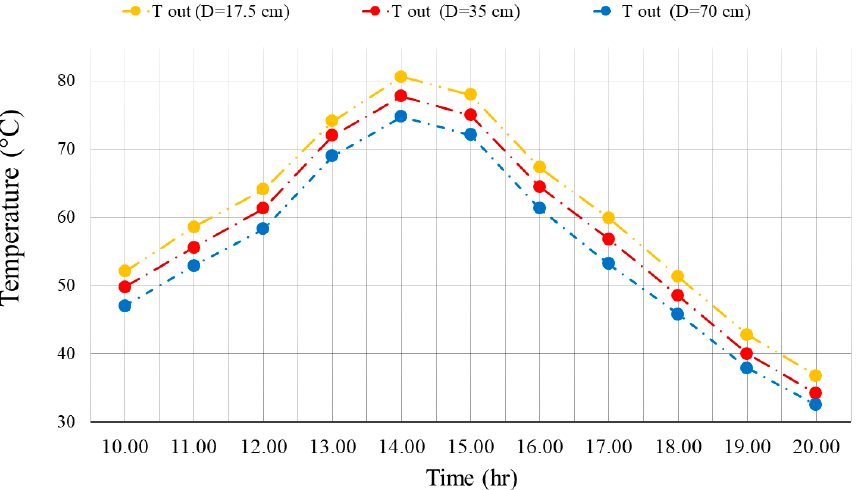
Figure 9. The effect of the size of the outlet and inlet valve on the outlet TEM of the wall at different times of the day in the presence of PCM.